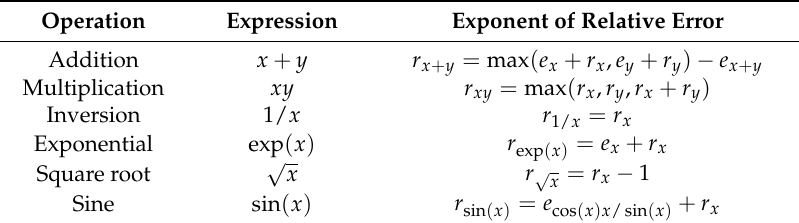
Table 1. Error propagation rules of each